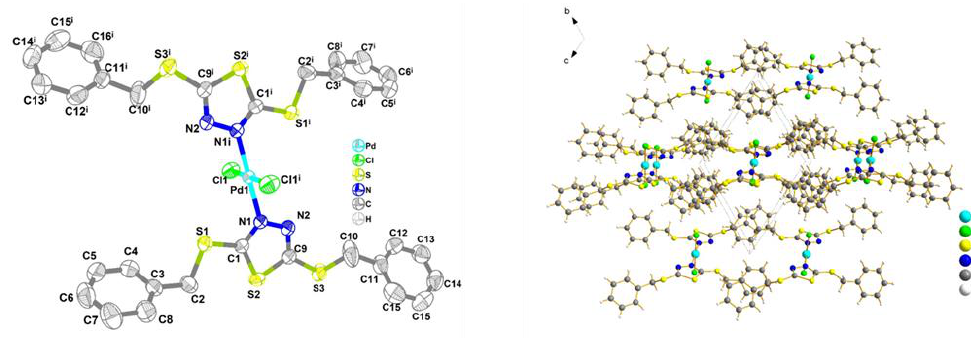
Figure 11. Crystal structure and the corresponding projection along the a-axis.